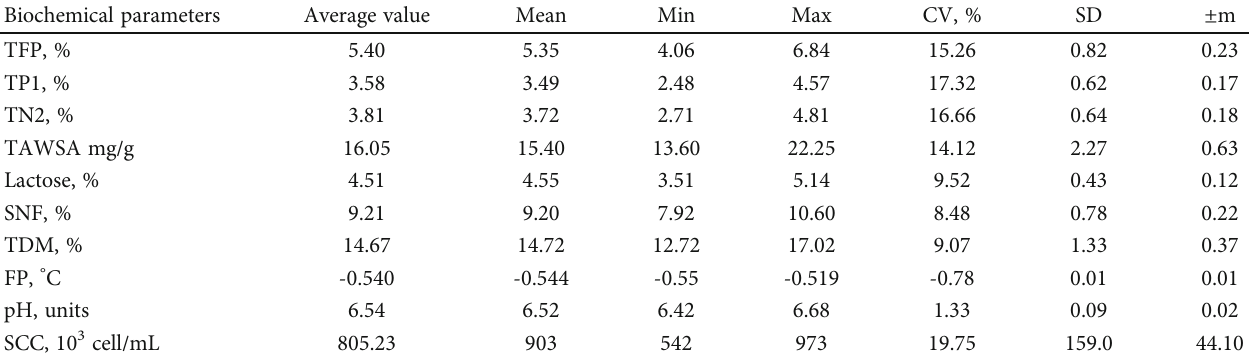
Table 3: The major biochemical parameters and component composition of milk samples ( n = 13 , group 3). Biochemical